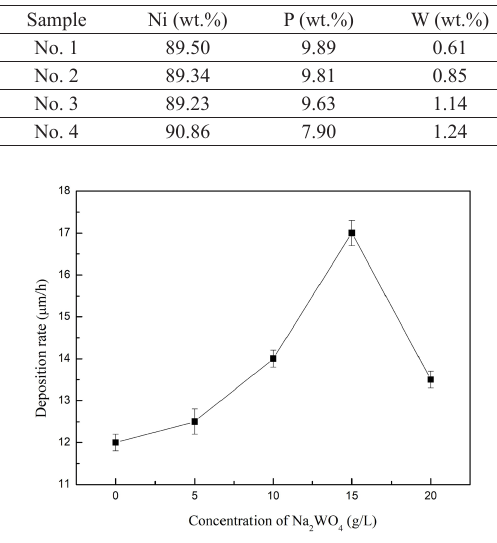
WO in plating solution 2 4